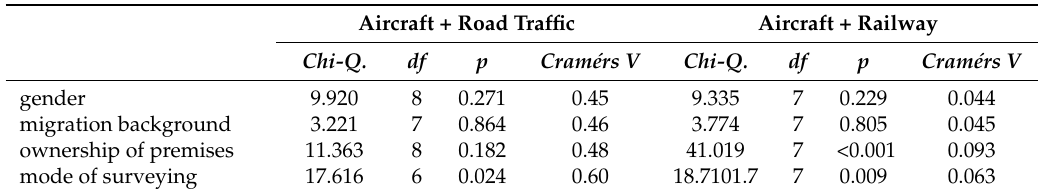
Table 5. Results independence tests of relevant socio-demographic covariates and mode of surveying for each sample.